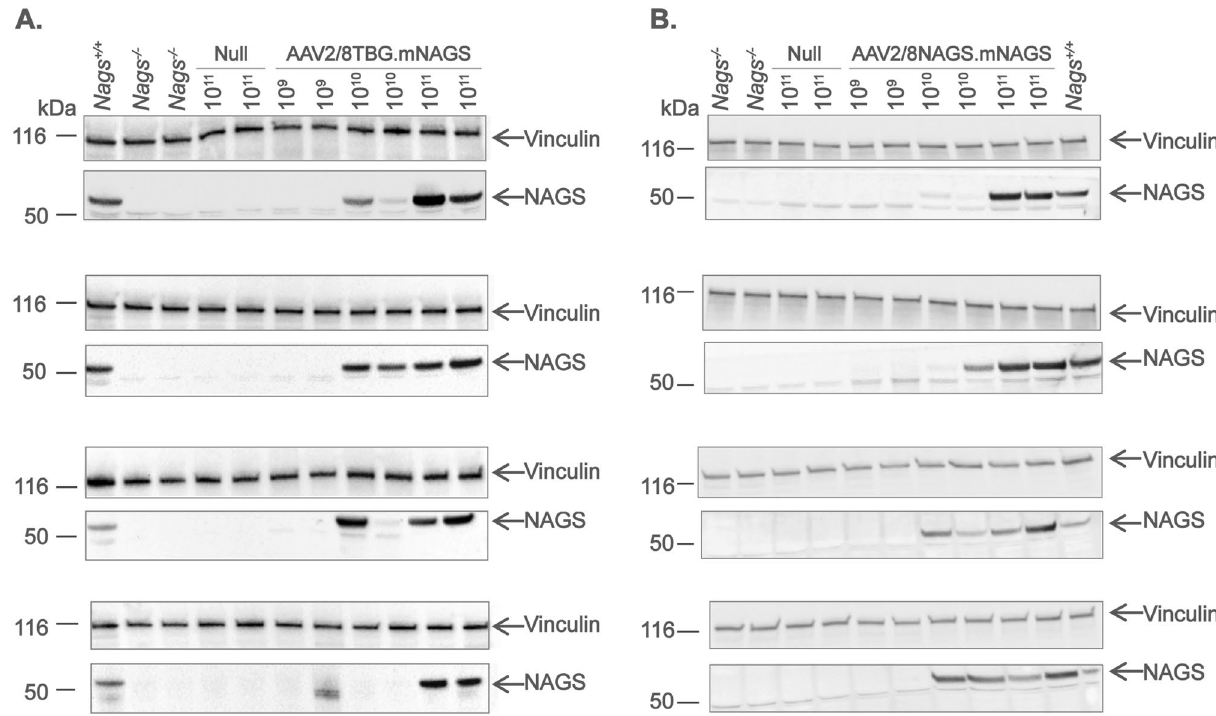
Figure 5. NAGS protein in the livers of Nags −/− mice after single injection with 10 11 particles of either AAV2/8TBG.mNAGS ( A ) or AAV2/8NAGS.mNAGS ( B ) vector. Vinculin was used as a loading control. Full- length immunoblots are presented in Supplementary Fig.